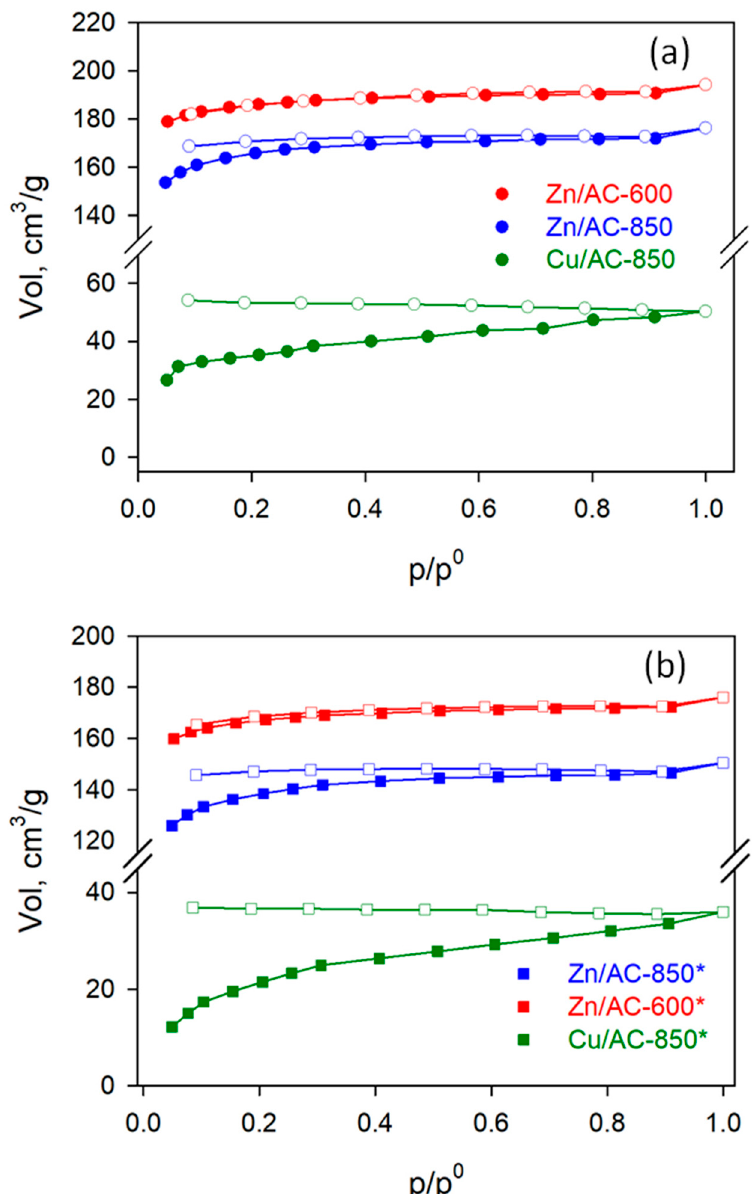
Figure 7. N 2 physisorption isotherms at 77 K for activated carbons pyrolyzed under pure helium ( a ) and under O 2 / He mixture ( b ) (closed symbols for adsorption branch, open symbols for desorption branch).